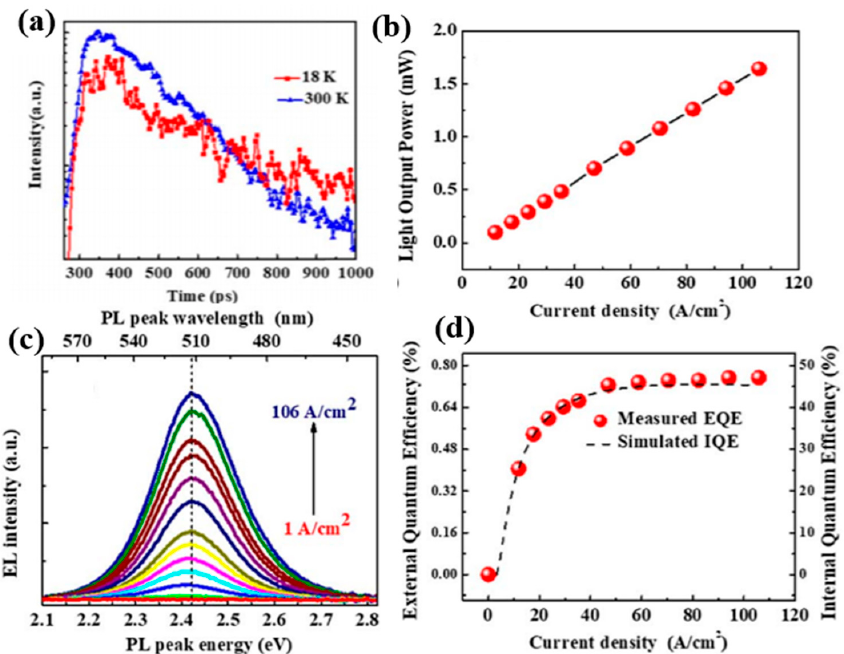
Figure 10. ( a ) TRPL measurements of capped QDs; ( b ) LOP versus injection current density; ( c ) electroluminescence spectra of QD LED; ( d ) EQE as a function of current density [72]. Figure reproduced with permission from Optical Society of America.